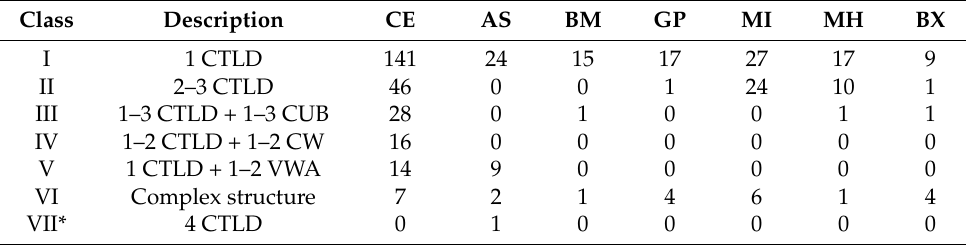
Table 2. Organization of proteins from the investigated nematode species containing